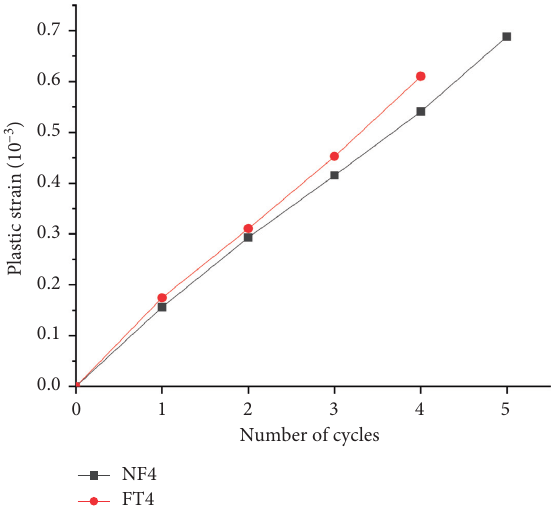
Figure 9: Curves of plastic strain with number of